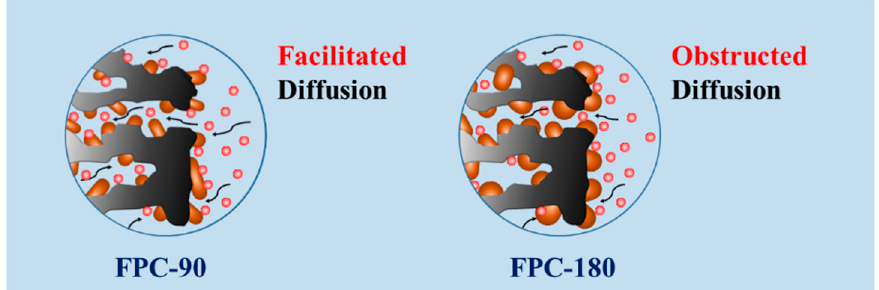
Figure 7. Effect of Fe 2 O 3 on the capacitance of composite electrode.